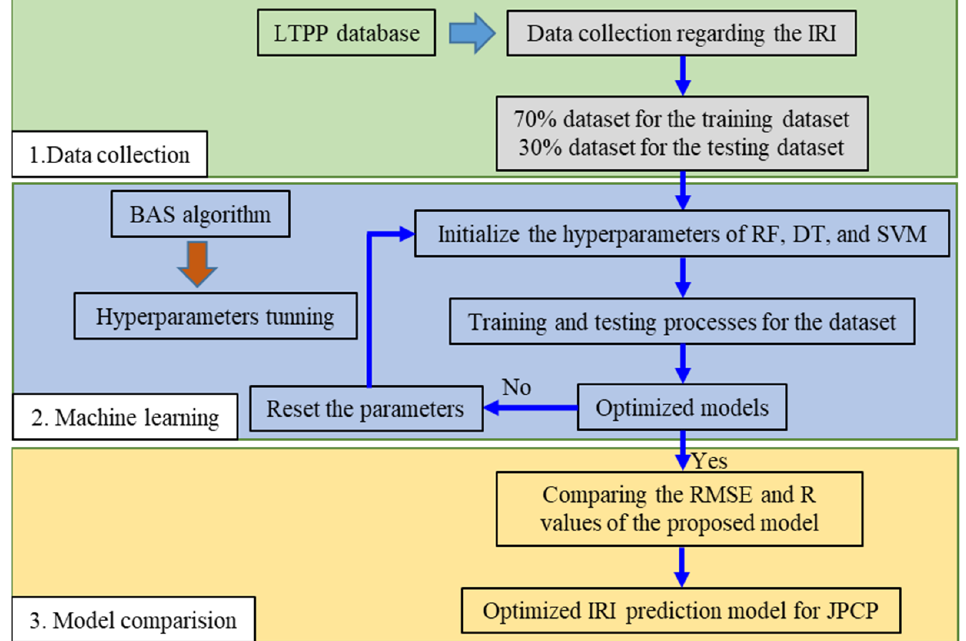
Figure 2. Flow chart of the research process. Table 1. Variable data